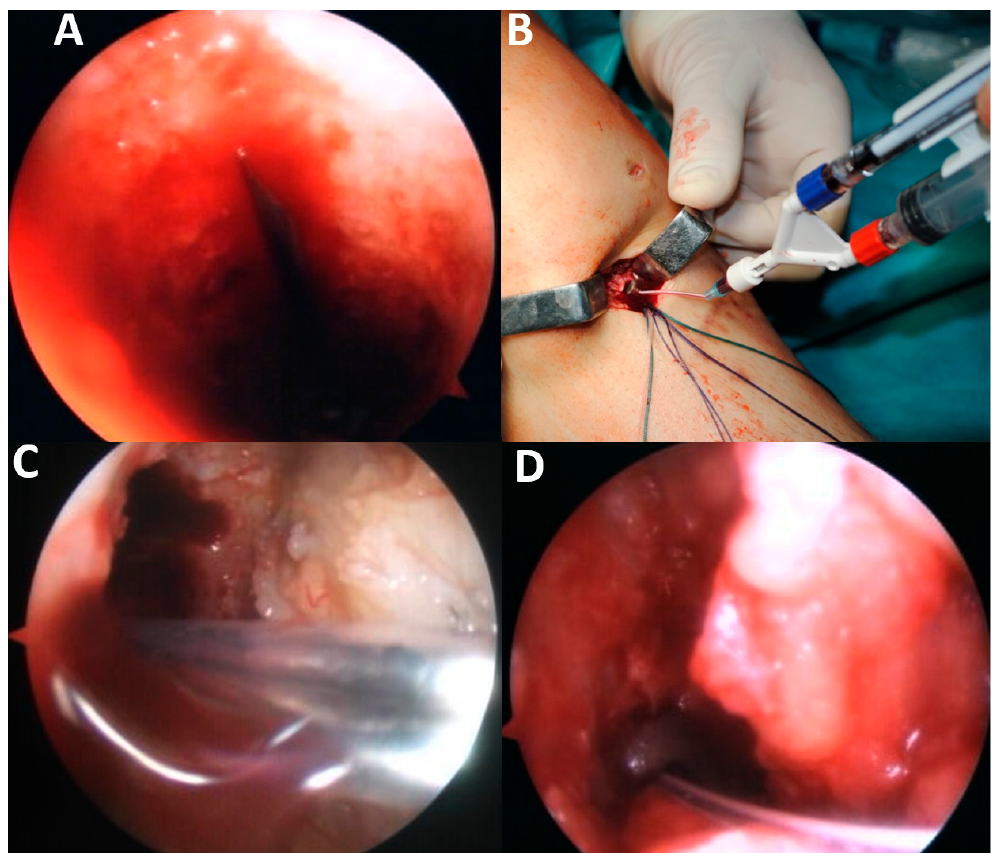
Figure 3. Administration of PRP into the reconstruction tunnels before and after quadriceps tendon bone graft insertion. Administration of the PRP in the tunnels: ( A ) tibial tunnel before the graft insertion, view from the anterolateral arthroscopic portal; ( B ) tibial tunnel after the graft insertion, through the interference screw; ( C ) femoral tunnel before the graft insertion, view from the anterolateral arthroscopic portal; ( D ) femoral tunnel after the graft insertion, through the interference screw, view from the anterolateral arthroscopic portal. PRP, platelet-rich plasma.